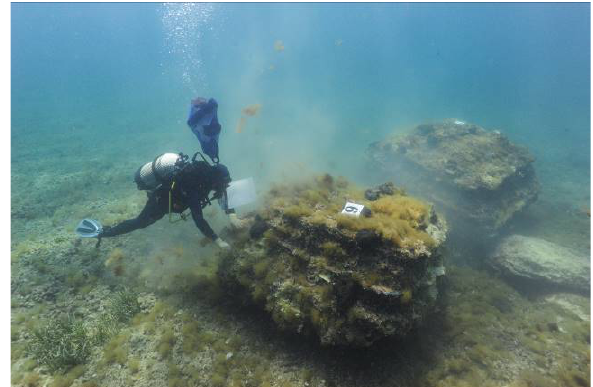
Figure 2. Marzamemi shipwreck. Detail of the squared blocks. (photo: D. Della Libera)